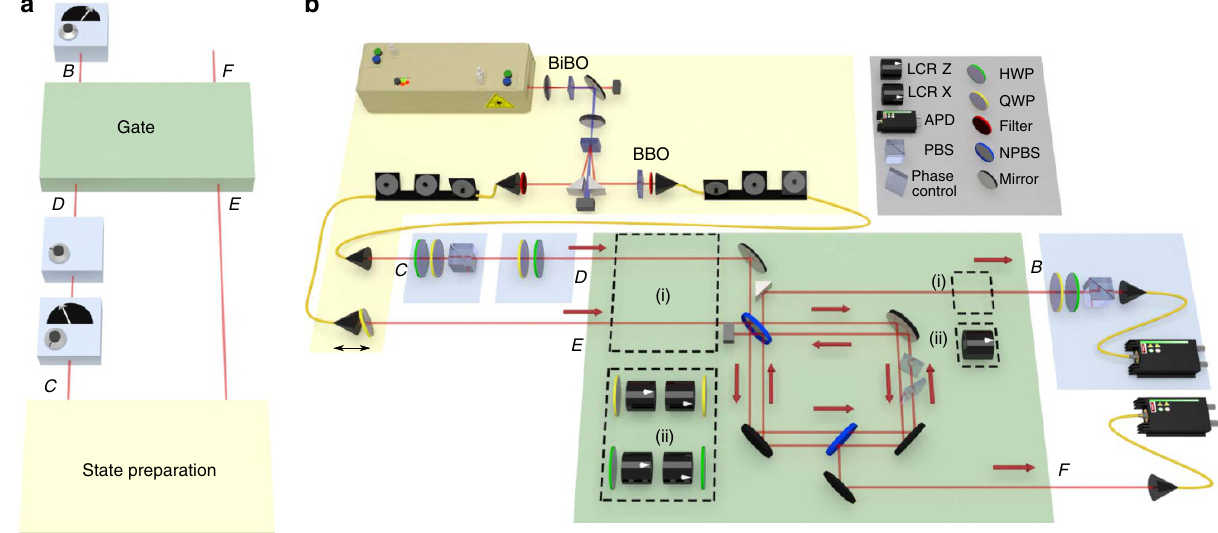
Figure 5 | Optical implementation of different causal relations. ( a ) Schematic diagram of the experiment. The gate allows the implementation of different ways of combining a common-cause relation (between C and B ) with a cause-effect relation (between D and B ). The initial preparation targets the maximally entangled state F þ j i . One photon is measured at C and reprepared at D ; then both are sent through the gate. The photon at B is detected in coincidence with the photon at F to post select only on those cases wherein a pair was produced. ( b ) Experimental set-up, including the polarization- entangled photon source and the partial swap, which implements the unitary U BF j DE ¼ 1 ffiffi p 1 B j D (cid:3) 1 F j E þ i 1 ffiffi p 1 B j E (cid:3) 1 F j D by tilting the glass plates to a 2 2 specific angle in the Sagnac interferometer. (i) For the quantum mixtures, no dephasing is applied and a translation stage adjusts the delay of the photon at E with respect to the one at D . (ii) For the classical mixtures, the LCRs and wave plates are used to apply complete dephasing on D , E and B , respectively. Notation for optical elements: bismuth-borate (BiBO), b -barium-borate (BBO), half-wave plate (HWP), quarter-wave plate (QWP), liquid-crystal retarder (LCR), polarizing beam splitter (PBS), non-polarizing beam splitter (NPBS), avalanche photo diode (APD).